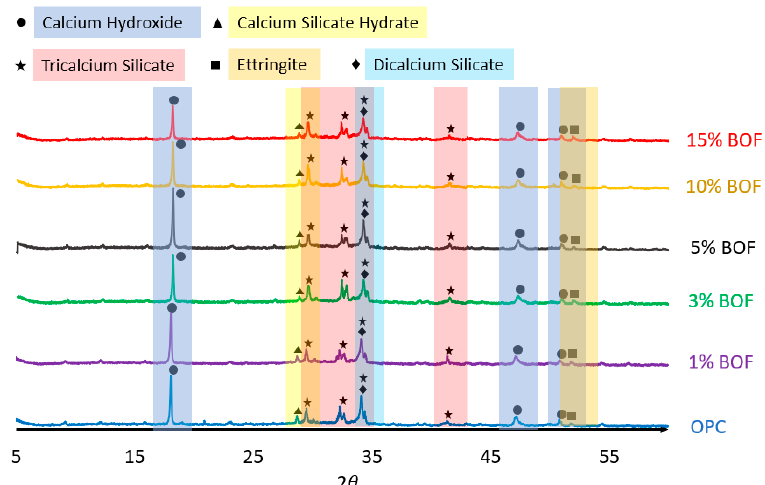
Figure 5. XRD results of the OPC and BOF-enhanced cement mortar with 1%, 3%, 5%, 10%, and 15% BOF at the early curing age of 3 days.